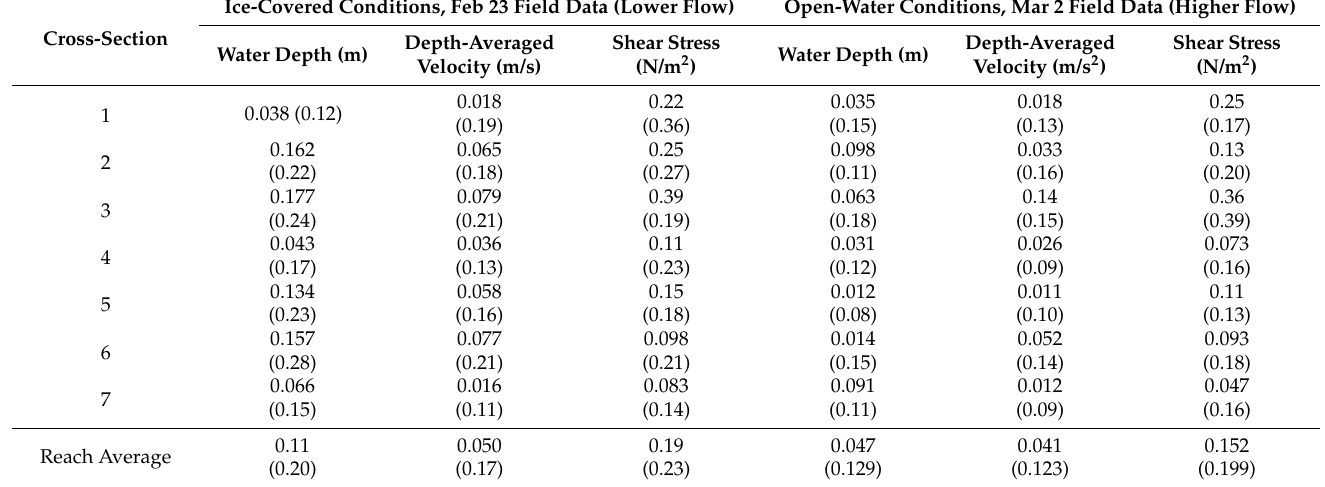
Table 3. Calculated MAE values for the modeled water depth, depth-averaged velocities, and shear stress values under lower flow, ice-covered conditions and measured data on 23 February 2021, and higher flow, open-water conditions and measured data on 2 March 2021. MAE values for the downsampled simulations models are shown in